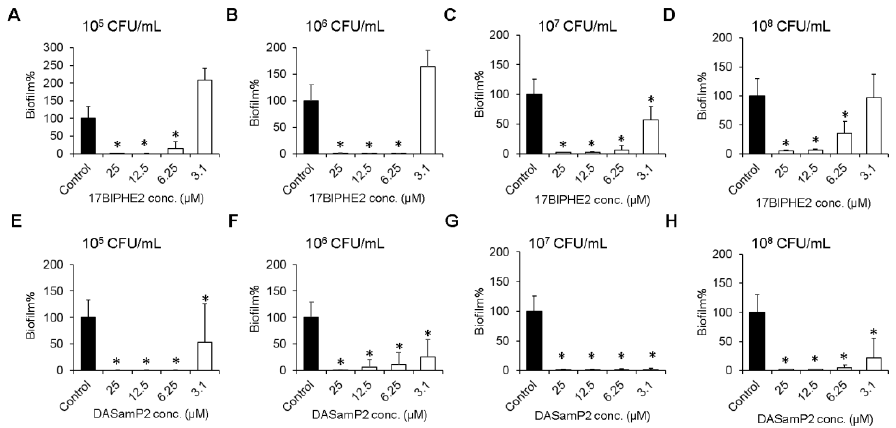
Figure 2. Inhibition of biofilm formation by 17BIPHE2 or DASamP2 at various amounts of P . aeruginosa PAO1 initial density: 10 5 CFU/mL ( A and E ), 10 6 CFU/mL ( B and F ), 10 7 CFU/mL ( C and G ) and 10 8 CFU/mL ( D and H ). p values were calculated based on paired Student’s t -test with two tailed distribution and values <0.05 were considered significant (*).